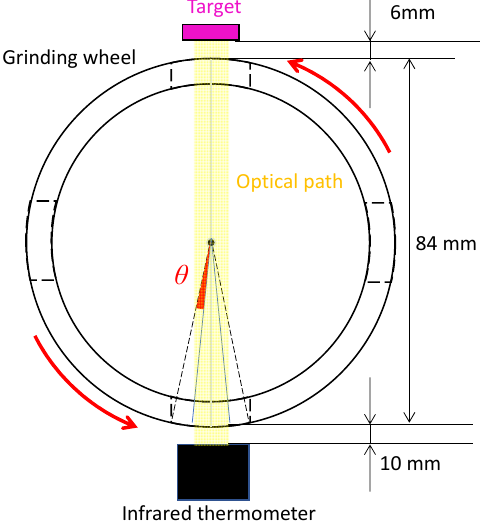
Figure 5. Aperture angle of grinding wheel (Type B). Table 1. Opening time, t 0 , for each grinding wheel and spindle speed .